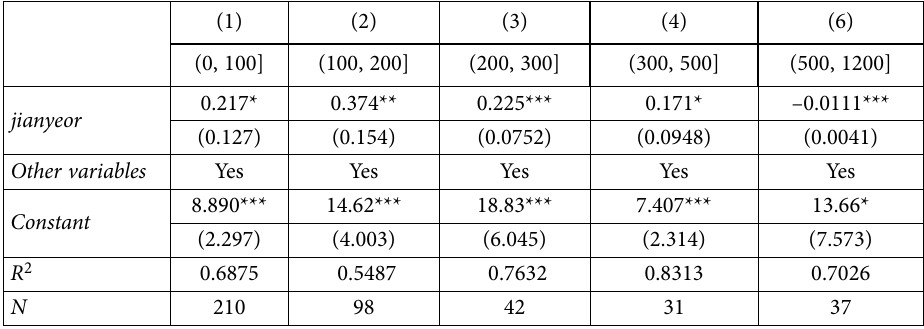
Table 5. Grouping heterogeneity regression results of total farmland area of farmer